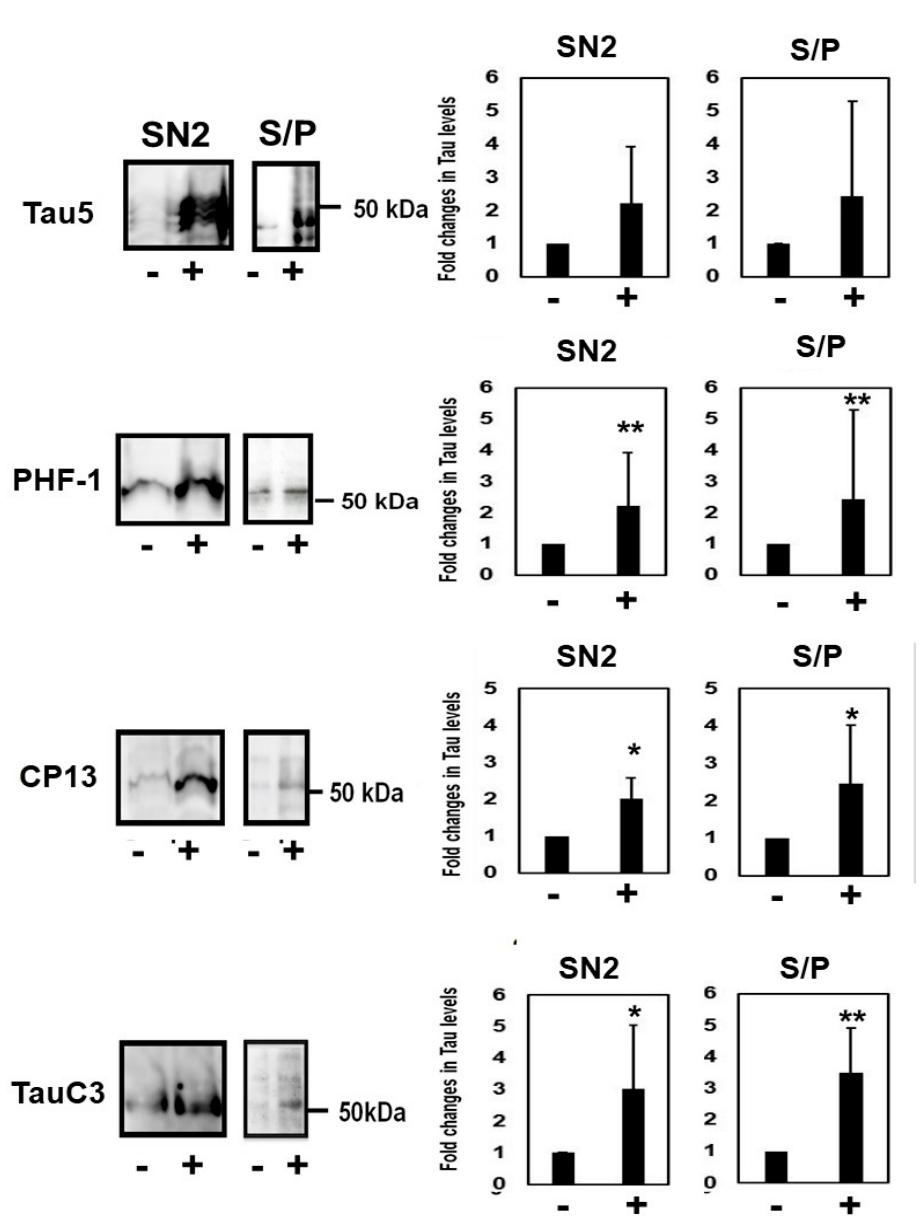
Figure 7. Homocysteine treatment increased sarkosyl-insoluble tau in M1C cells. Lysate from M1C cells induced to express tau for 5 days was treated with 100 µ M L-homocysteine (Hcy) on day 4, and then fractionated into SN1 (buffer soluble), SN2 (buffer insoluble and sarkosyl-soluble), and S/P (sarkosyl-insoluble pellet) fractions. Each fraction was analyzed by Western blot analysis using Tau5, PHF-1, CP13, and TauC3 antibodies. Compared with control cells, the increase of tau was observed in all fractions, including the sarkosyl insoluble fraction obtained from cells treated with 100 µ M Hcy. − : 0 µ M Hcy, +: 100 µ M Hcy treated cells. Bar: ± SD, * p < 0.05, ** p < 0.01.